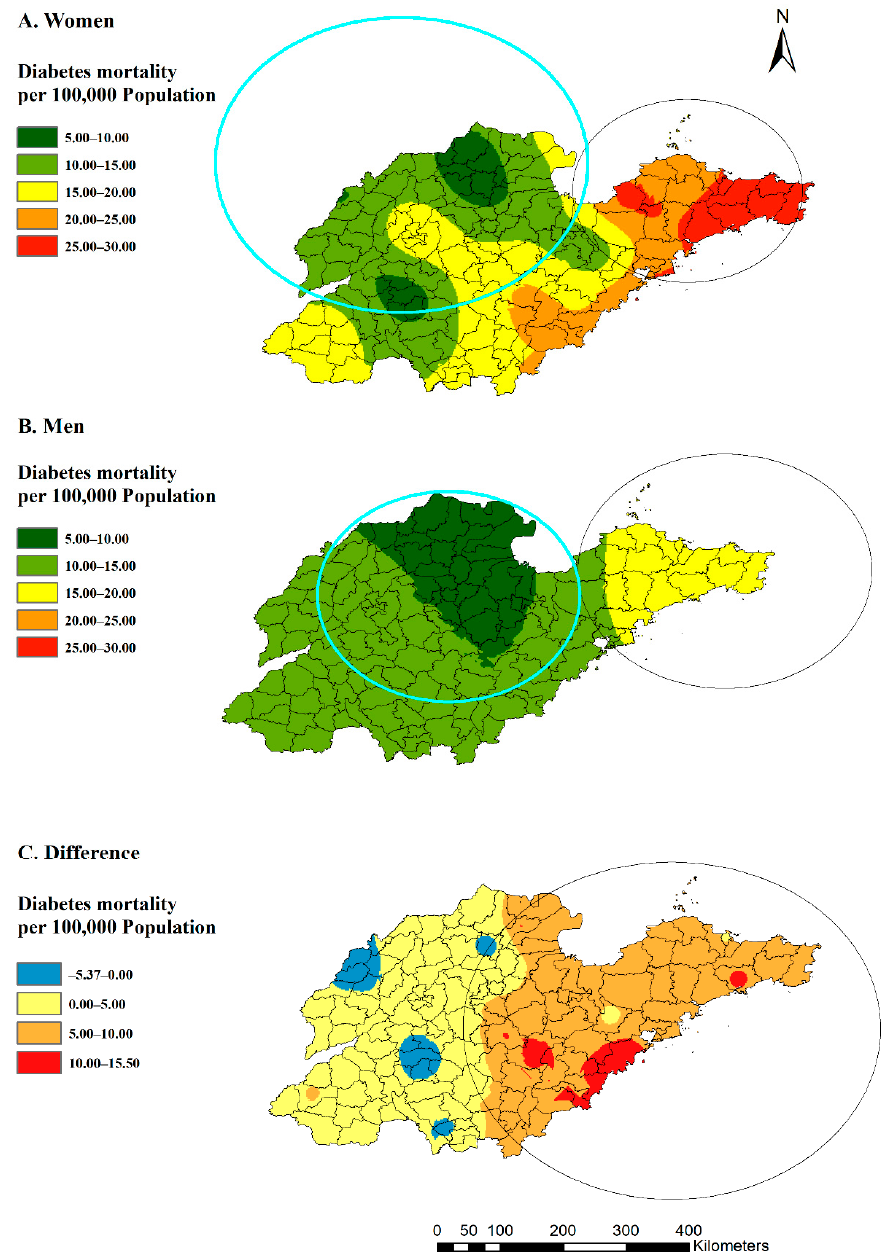
Figure 5. Estimated diabetes mortality by gender ( A , B ) and distribution of rates differences between women and men ( C ) with clusters in Shandong Province, China, 2014.